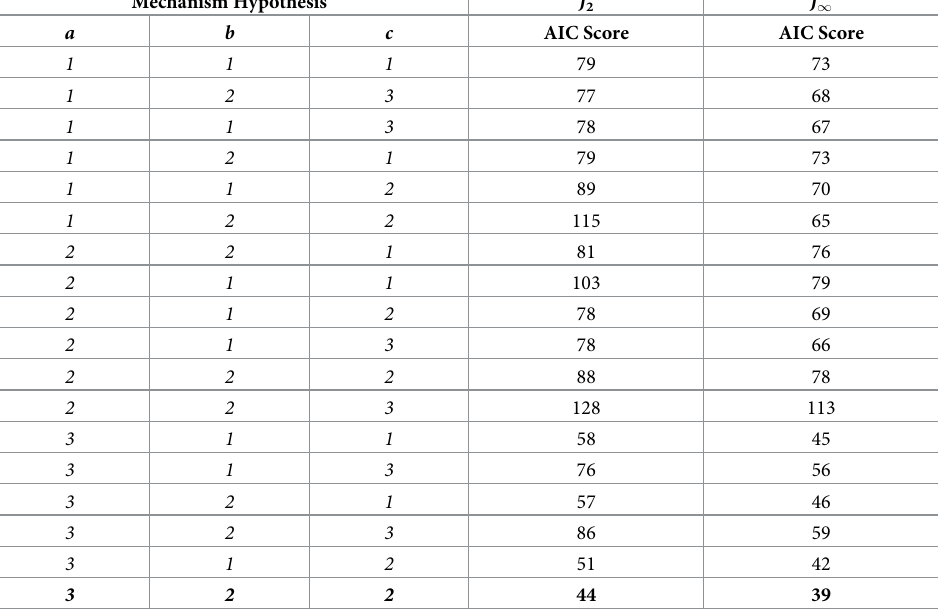
Table 2. Akaike information criterion (AIC) for comprehensive ODE of all 18 combinations of hypotheses. Left columns denote the hypotheses from each of three mechanisms tested. The AIC scores resulting from J 2 and J 1 minimization for each model are shown on the right and vary dramatically across models. Comparing AICs reveal one best combination (boxed in red) and the worst fitting model is highlighted in blue